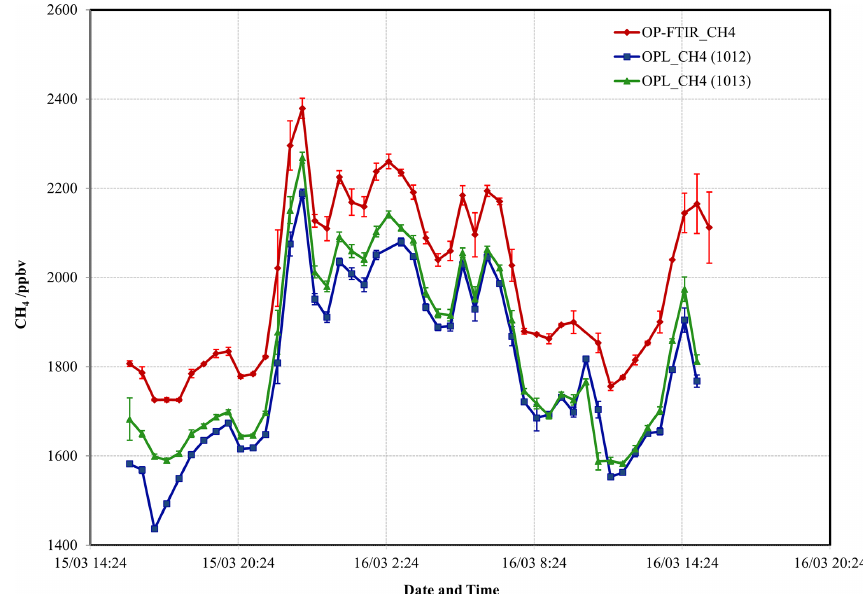
Figure 8. The 30min averaged CH 4 mole fraction measured by OP-FTIR and both OPL units (1012 and 1013) positioned side-by-side (path length = 148m) at Wollongong site. Error bars denote the standard error.